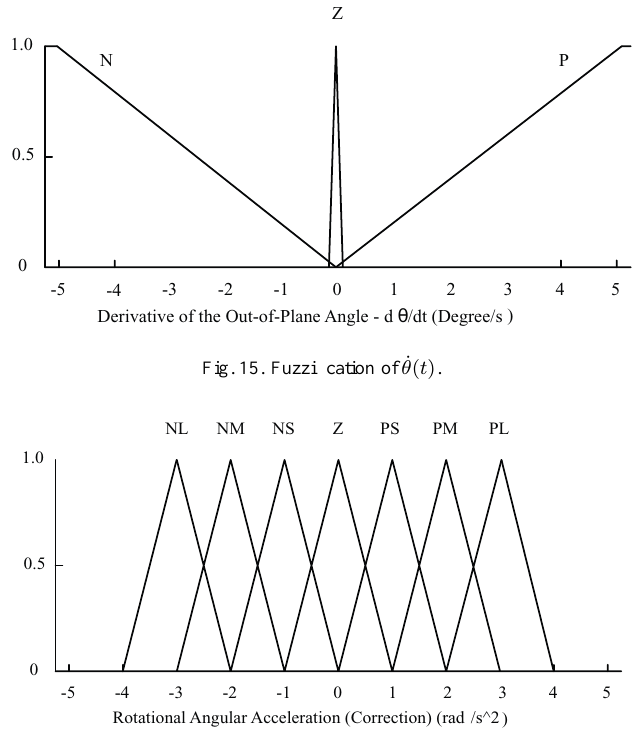
Fig. 16. Defuzzification of ¨ γ Correction